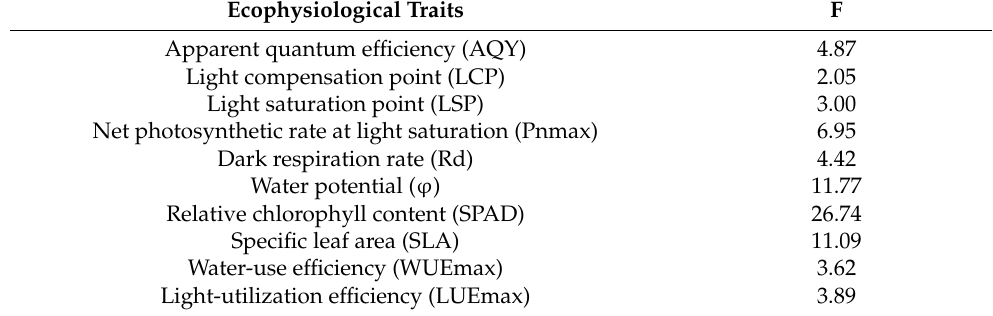
Table 2. One-way ANOVA of leaf ecophysiological traits of 47 species. F-values are shown, p < 0.05 for all F values.